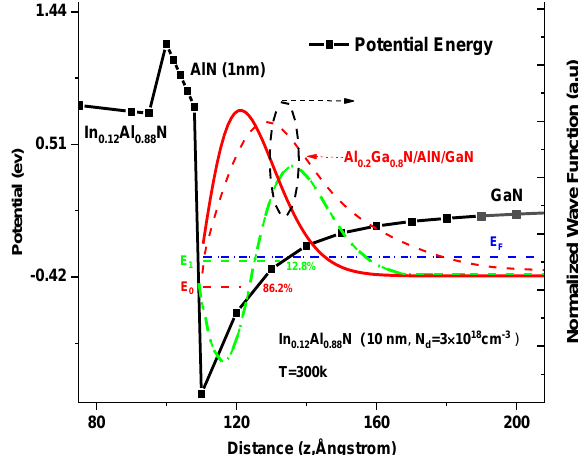
Figure 3. The conduction band profile of the In 0.12 Al 0.88 N/AlN/GaN heterostructure and the wave function of the ground state ( i = 0, red, line) and first excited ( i = 1, green, dash) under room temperature. A normalized first subband wave function for an Al 0.2 Ga 0.8 N/AlN/GaN (red, short dash) is given for